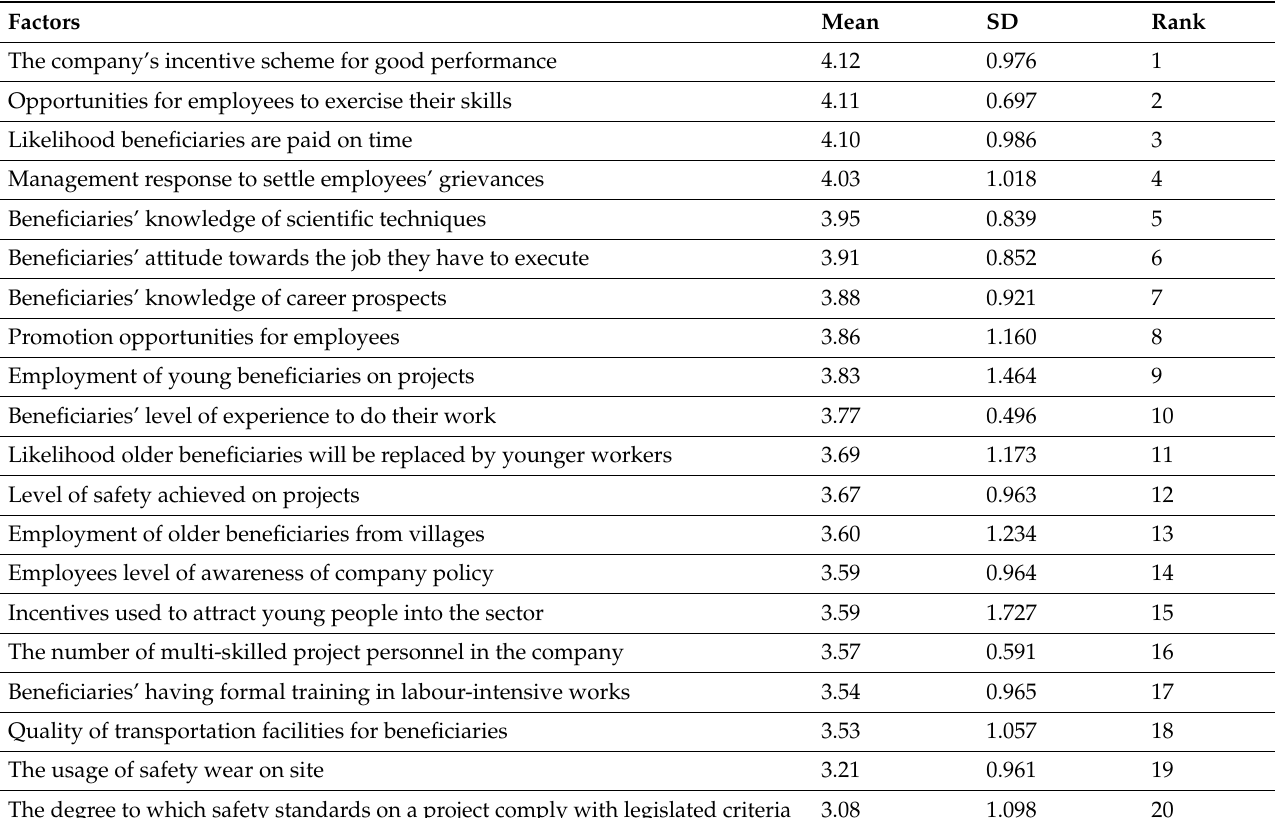
Table 2. Descriptive statistics for worker component (WC).